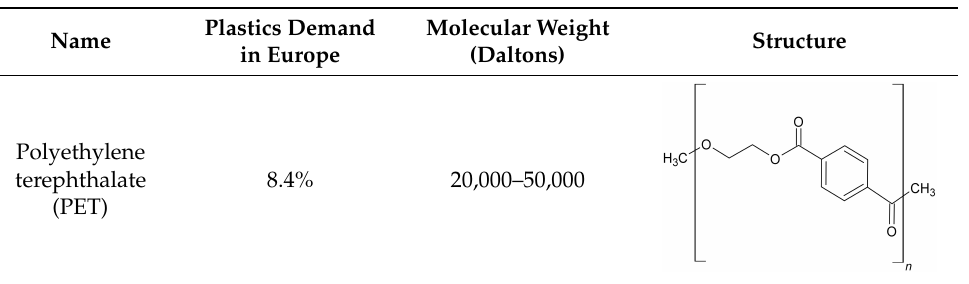
Table 3. European plastic demand, molecular weight (Daltons) and backbone structural formula of polyethylene